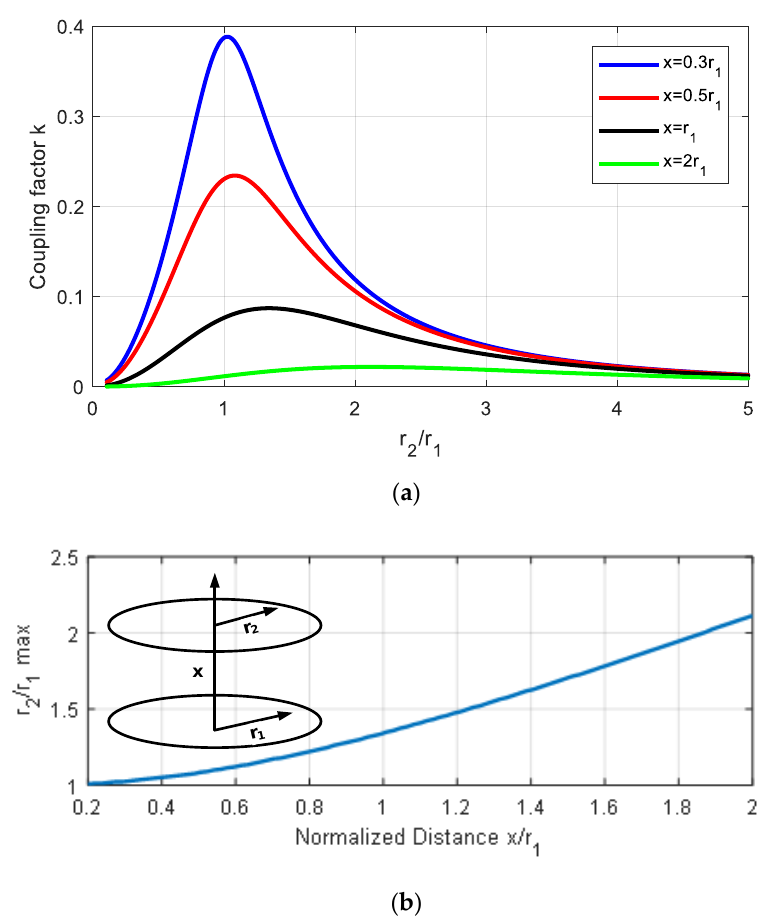
Figure 5. ( a ) Simulated coupling factor as a function of the radius of loop antennas r 2 / r 1 for different axial distances. ( b ) Optimum ratio of the radius as a function of the normalized axial distance x / r 1 .